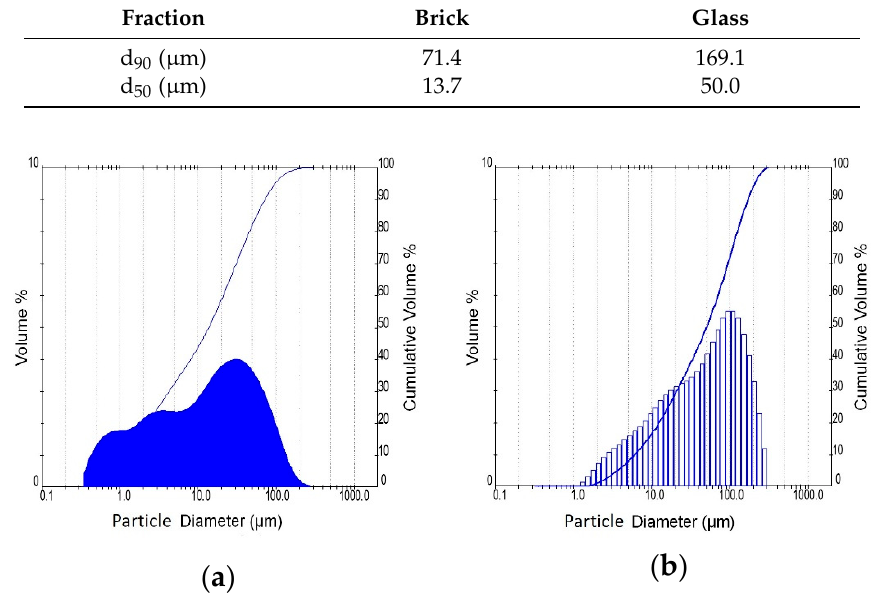
Table 1. Fineness characteristics of CDW brick and glass.